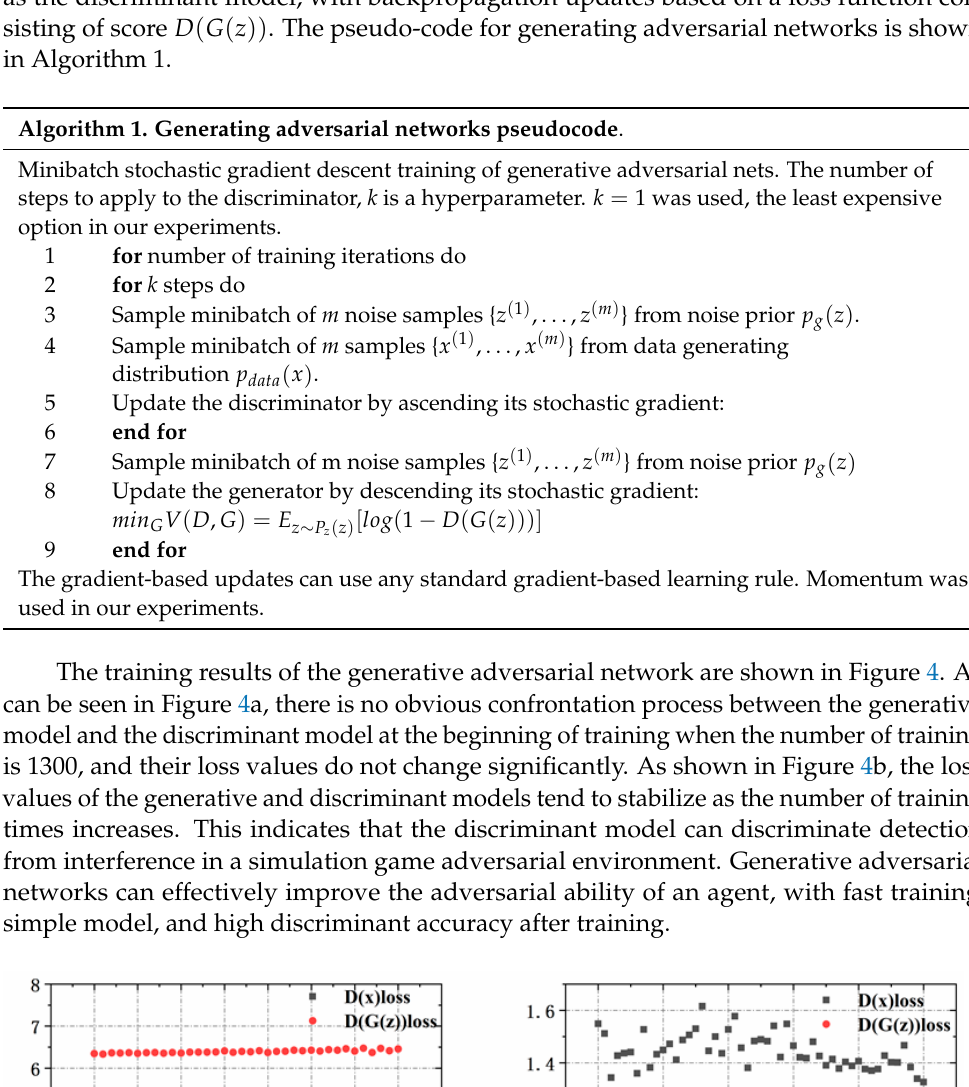
Algorithm 1. Generating adversarial networks pseudocode .